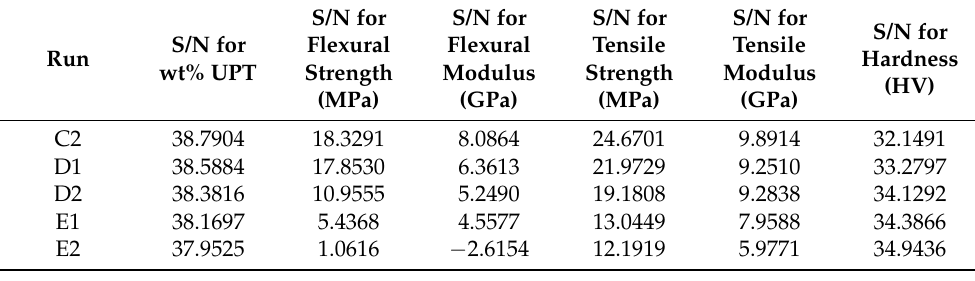
Table 3. Experimental result of the S/N ratio values for hybrid